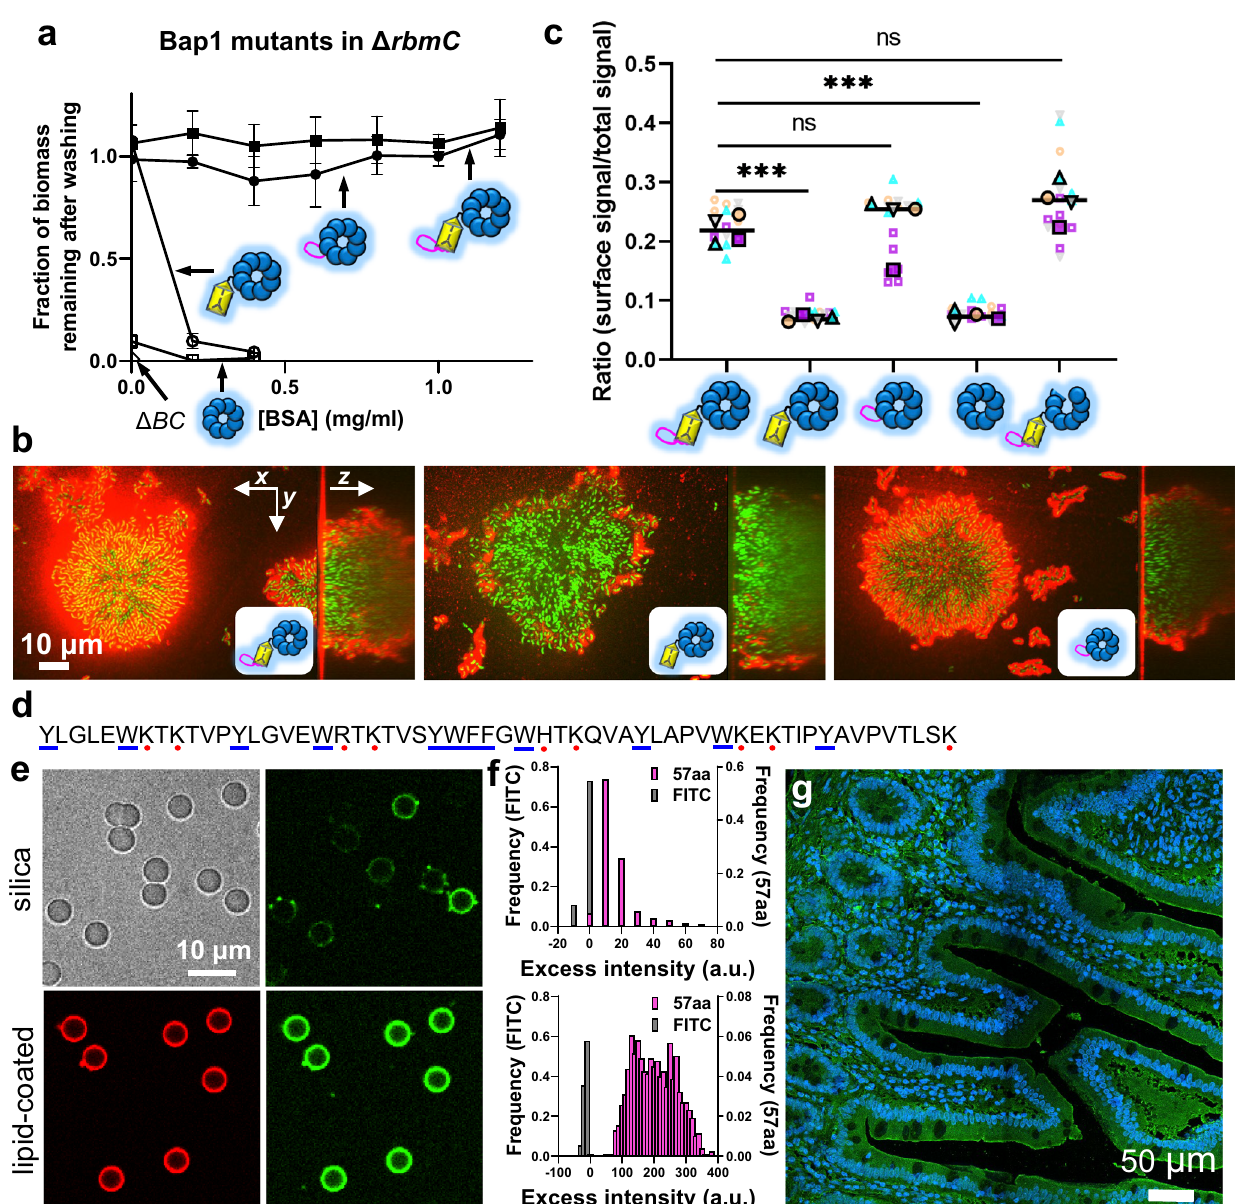
Fig. 3 | Bap1 possesses a unique 57-amino acid loop with broad, nonspeci fi c adhesion. a Bio fi lm adhesion assay for different Bap1 mutants (structure shown schematically) in a Δ rbmC strain background. BSA was used during bio fi lm growth at increasing concentrations as a non-speci fi c competitor for glass surface adhe- sion. Δ BC denotes the Δ bap1 Δ rbmC double mutant. All data are depicted as the mean±SD ( n =3 biologically independent samples). b , c In situ staining and asso- ciated quanti fi cation of bio fi lms formed by different Bap1 mutants, tagged by 3×FLAGatthe C-terminus and labeledusing anti-FLAG-Cy3. Note afunctionalcopy ofRbmCispresentinthisassaytoanchorthebio fi lmstothesubstrateregardlessof whether the mutant Bap1 is functional. b Representative cross-sectional images of the bottom layer and side views of bio fi lms formed by cells expressing WT Bap1 ( Left ), Bap1 Δ 57aa ( Middle ), and Bap1 Δβ -prism B +57aa ( Right ). c Quanti fi cation of Bap1 localization within the bio fi lm for different mutants (structure shown schemati- cally). Shown are the ratios between the immunosignals of 3×FLAG-tagged Bap1 at the bio fi lm-glass interface and the total signal integrated over the entire bio fi lm